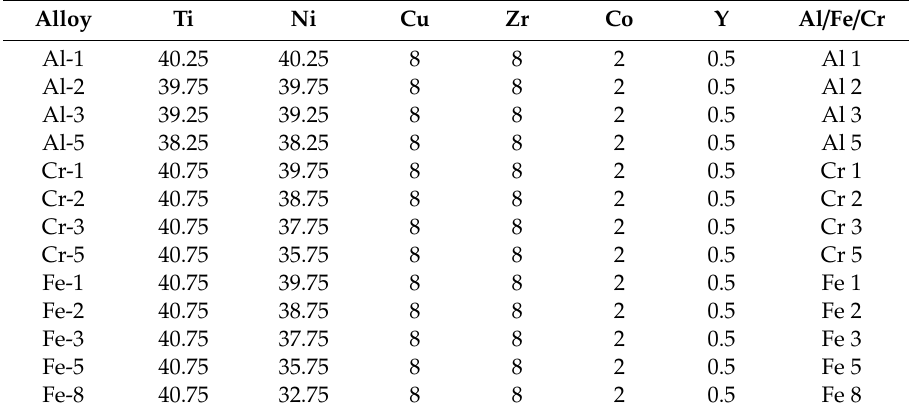
Table 1. Chemical composition of the studied alloys (in atomic